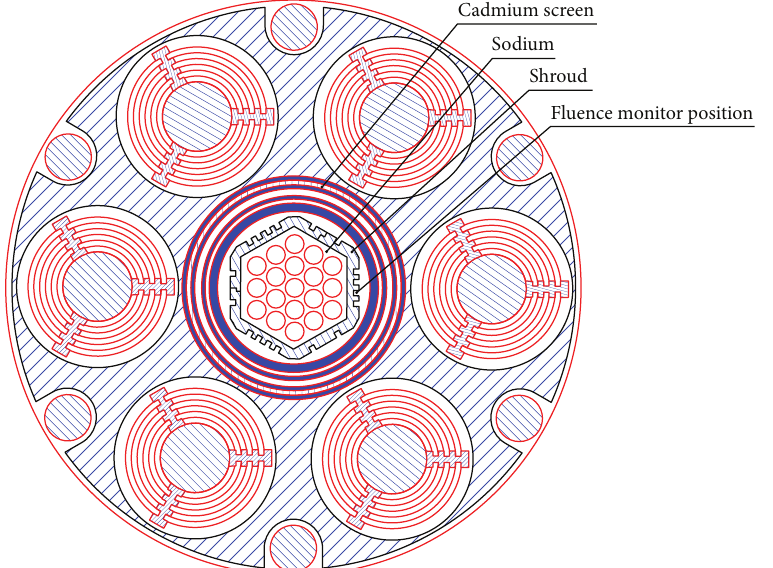
Figure 3: Horizontal cross-section of the MOL 7D loop with 19 fuel pins in the central 200 mm diameter BR2 channel